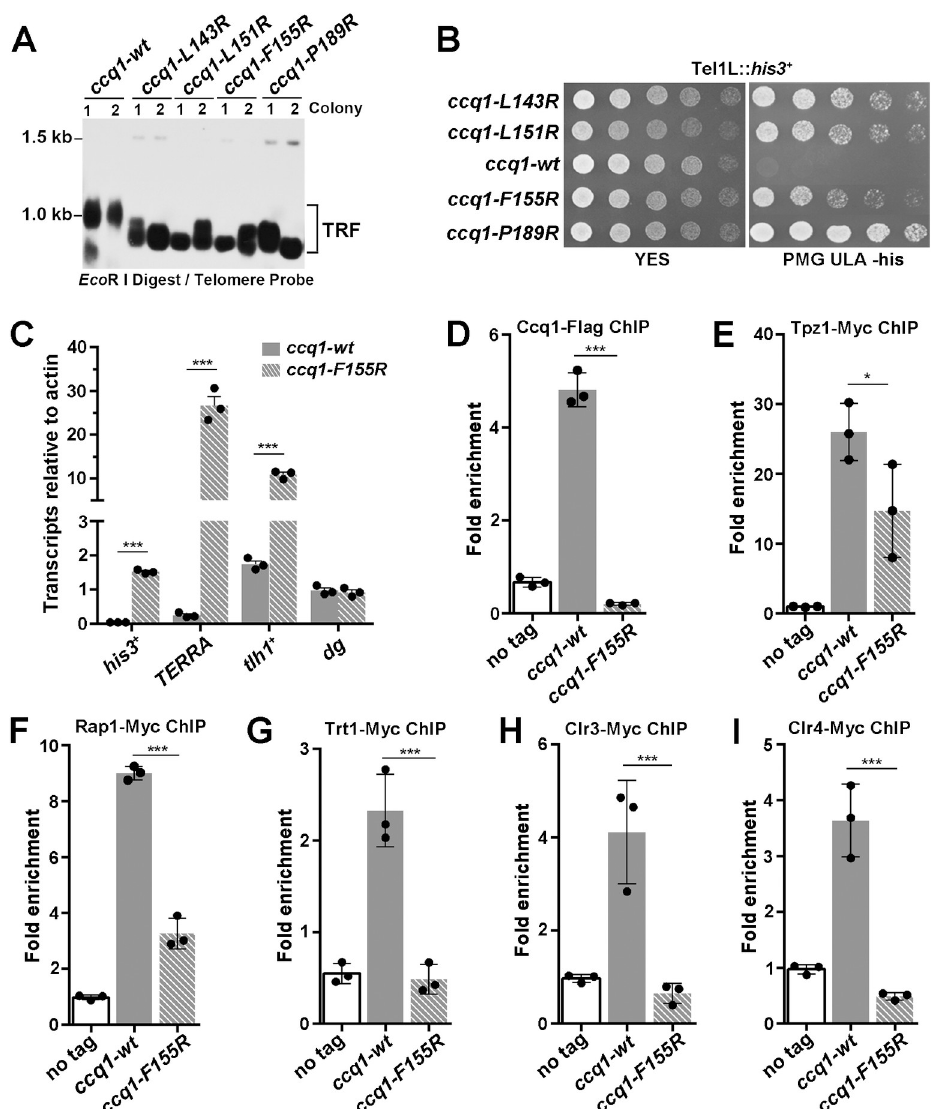
Fig 4. Functional analysis of the Tpz1-Ccq1 interaction in telomere maintenance and telomeric heterochromatin formation. (A) Southern blot analysis of telomere lengths of wild-type or Tpz1-binding deficient Ccq1 mutant strains. Genomic DNAs were digested with Eco R I and subjected to Southern blot analysis with a telomere-specific probe. (B) Effects of Tpz1-binding deficient mutations of Ccq1 on the transcriptional silencing of his3 + reporter gene inserted adjacent to the telomeric region. Equal amounts of 10-fold dilution series of cultures were spotted on YES or Pombe Medium Glutamate supplemented with uracil, leucine, and adenine (PMG ULA) (-histidine) plates. (C) RT-qPCR analysis of the transcription of TERRA and tlh1 + in the wild-type and ccq1-F155R cells. The transcription at the cen-dg region was used as a control. Data are represented as mean ± s.e.m. from three independent experiments. (D-I) Effects of the Ccq1-F155R mutation on telomere association for Ccq1 (D), Tpz1 (E), Rap1 (F), the telomerase catalytic subunit Trt1 (G), the deacetylase subunit Clr3 of the SHREC complex (H) and the methyltransferase subunit Clr4 of the CLRC complex (I) were measured by ChIP-qPCR assays. Recruitment to the internal act1 + locus serves as a control for ChIP specificity. Data are represented as mean ± s.e.m. from three independent